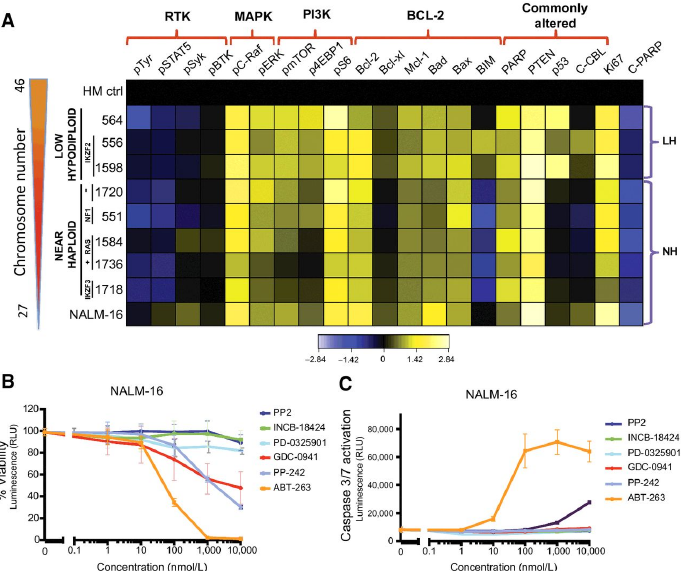
Figure 7. Integrated biochemical characterization with viability/survival assays in hypodiploid ALL. ( A ) Cytobank heatmap representing a signaling profiling panel of phospho- and total protein levels (columns) in individually xenografted leukemias from LH and NH subtypes (rows). Levels of phospho- and total proteins were normalized to healthy donor control cells (HM ctrl). Yellow, increased levels; blue, decreased levels. ( B , C ) NALM-16 cells were cultured for 24 h in the presence of increasing concentrations of inhibitors (PP2, INCB-18424, GDC-0941, PP-242, PD-0325901, and ABT-263) and effects were measured using cell proliferation ( B ) and apoptosis levels ( C ) using ATP- luminescence (CellTiter Glo) or caspase-3/7 activation assays, respectively [42] The main counters for the computational study are displayed in ( B ) cell proliferation and ( C ) ATP-Luminescence. These counters are selected for the implementation of the membrane system, as the variance in the values make them a good fit for evolving during the evolution process of the membrane system. Reproduced with permission from Ernesto Díaz-Flores, Cancer Research, published by American Association for Cancer Research, 2019